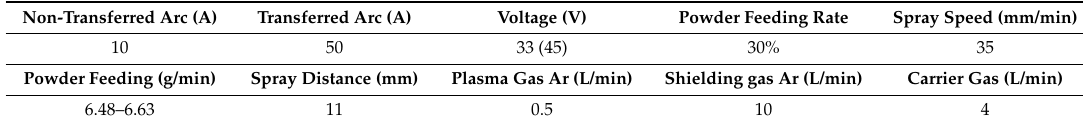
Table 3. Parameters of plasma spray welding.